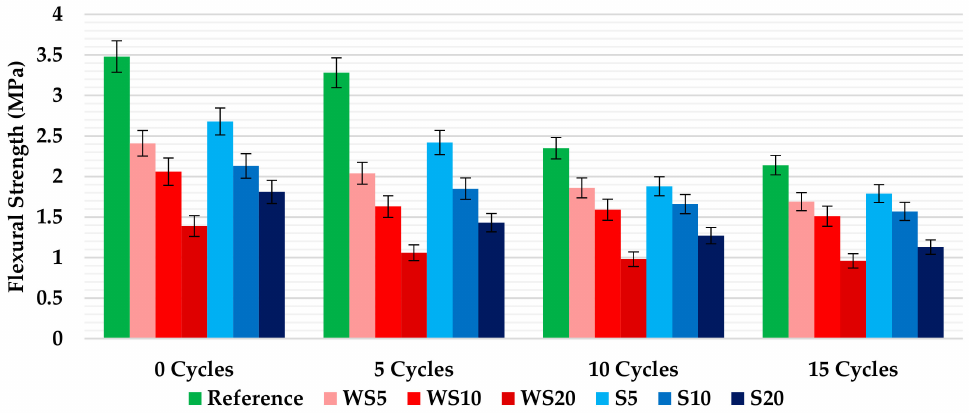
Figure 10. Flexural strength of the plasters after 0, 5, 10, and 15 wetting–drying cycles.